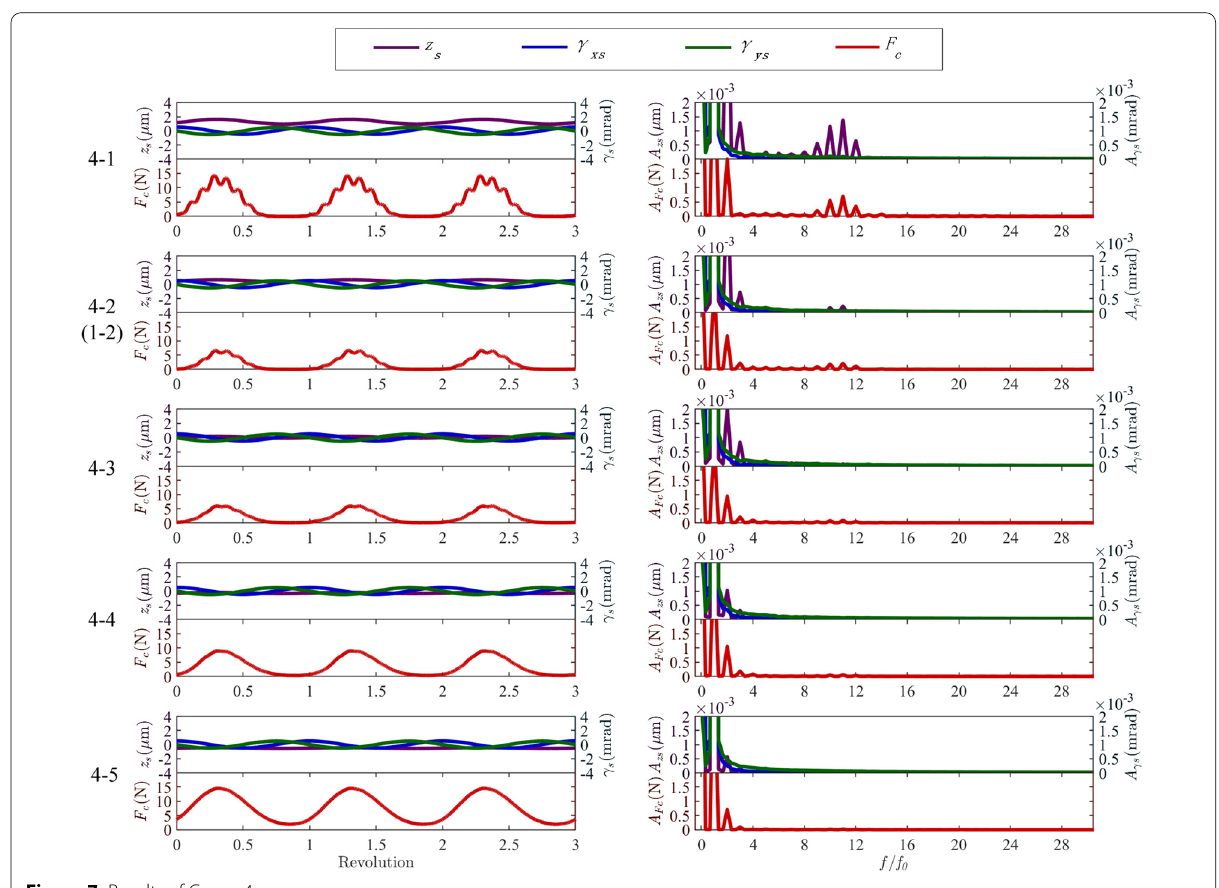
Figure 7 Results of Group 4